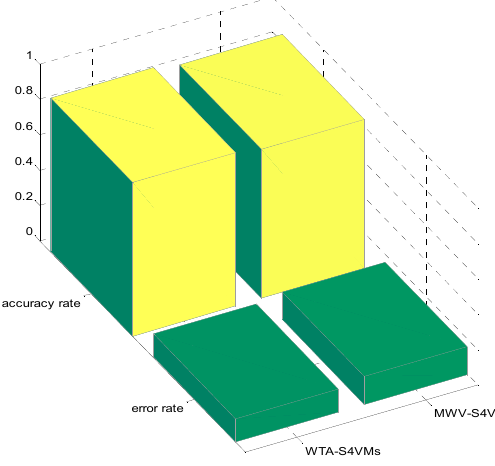
Figure 1. Total accuracy of the two multi-classification methods.